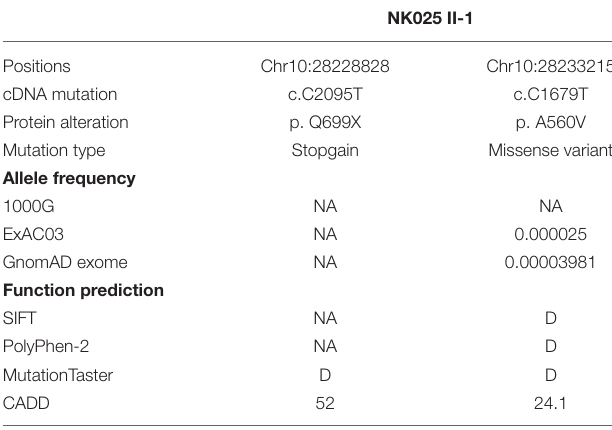
TABLE 1 | Overview of the identified ARMC4